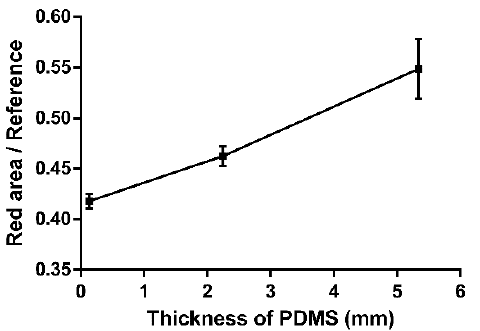
Figure 6. Calibration curve for the image detection ratio and thickness. The parameters are calculated according to the area of the red-light circle divided by the area of the sample edge. Three different thicknesses were considered: 0.135, 2.247 and 5.343 mm. The parameters were 0.418, 0.462 and 0.549, respectively.